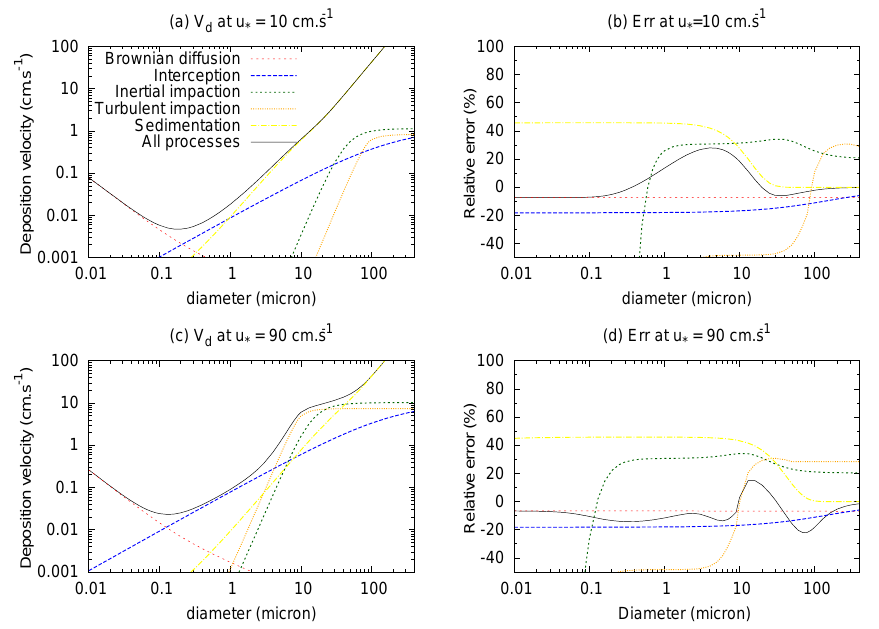
Fig. 1. Deposition on long grass (LUC 14) and influence of the different processes under low and wind high conditions ( u ∗ = 10 and 90cms − 1 ). The canopy is characterized by h = 0 . 77m, LAI = 4, z 0 = 0 . 1m and d = 0 . 49m, while ρ p = 1500kgm − 3 . The deposition velocity at z R = 5m, predicted by the present model, is given on the left hand side. The relative error Err between the present model and the 1-D-model is given on the right hand side, when the different processes are considered separately or together. Table 2. Coefficients for different Land Use Categories (LUC). The obstacle shape chosen to represent the LUC is given in brackets as N for needle and L for leaf or plane obstacles. (*) For the mixed wood forest and transitional forest, the deposition velocity for the evergreen needleleaf forest (LUC 4) and for the deciduous broadleaf forest (LUC 7) are calculated and the resulting deposition velocity for the mixed wood forest and the transitional forest is estimated as the average weighted by the proportion of tree